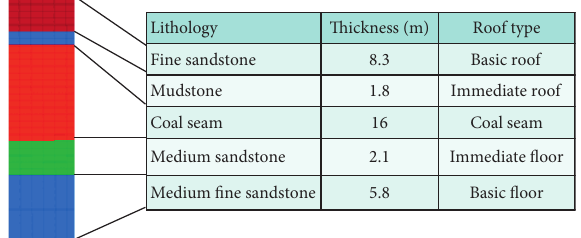
Figure 1: Generalized stratigraphy column of the working